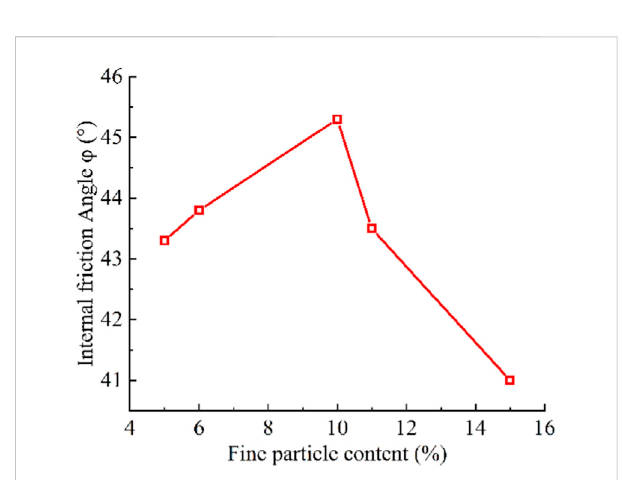
FIGURE 8 Relationship curvebetweenthe fi ne particle content and internal friction